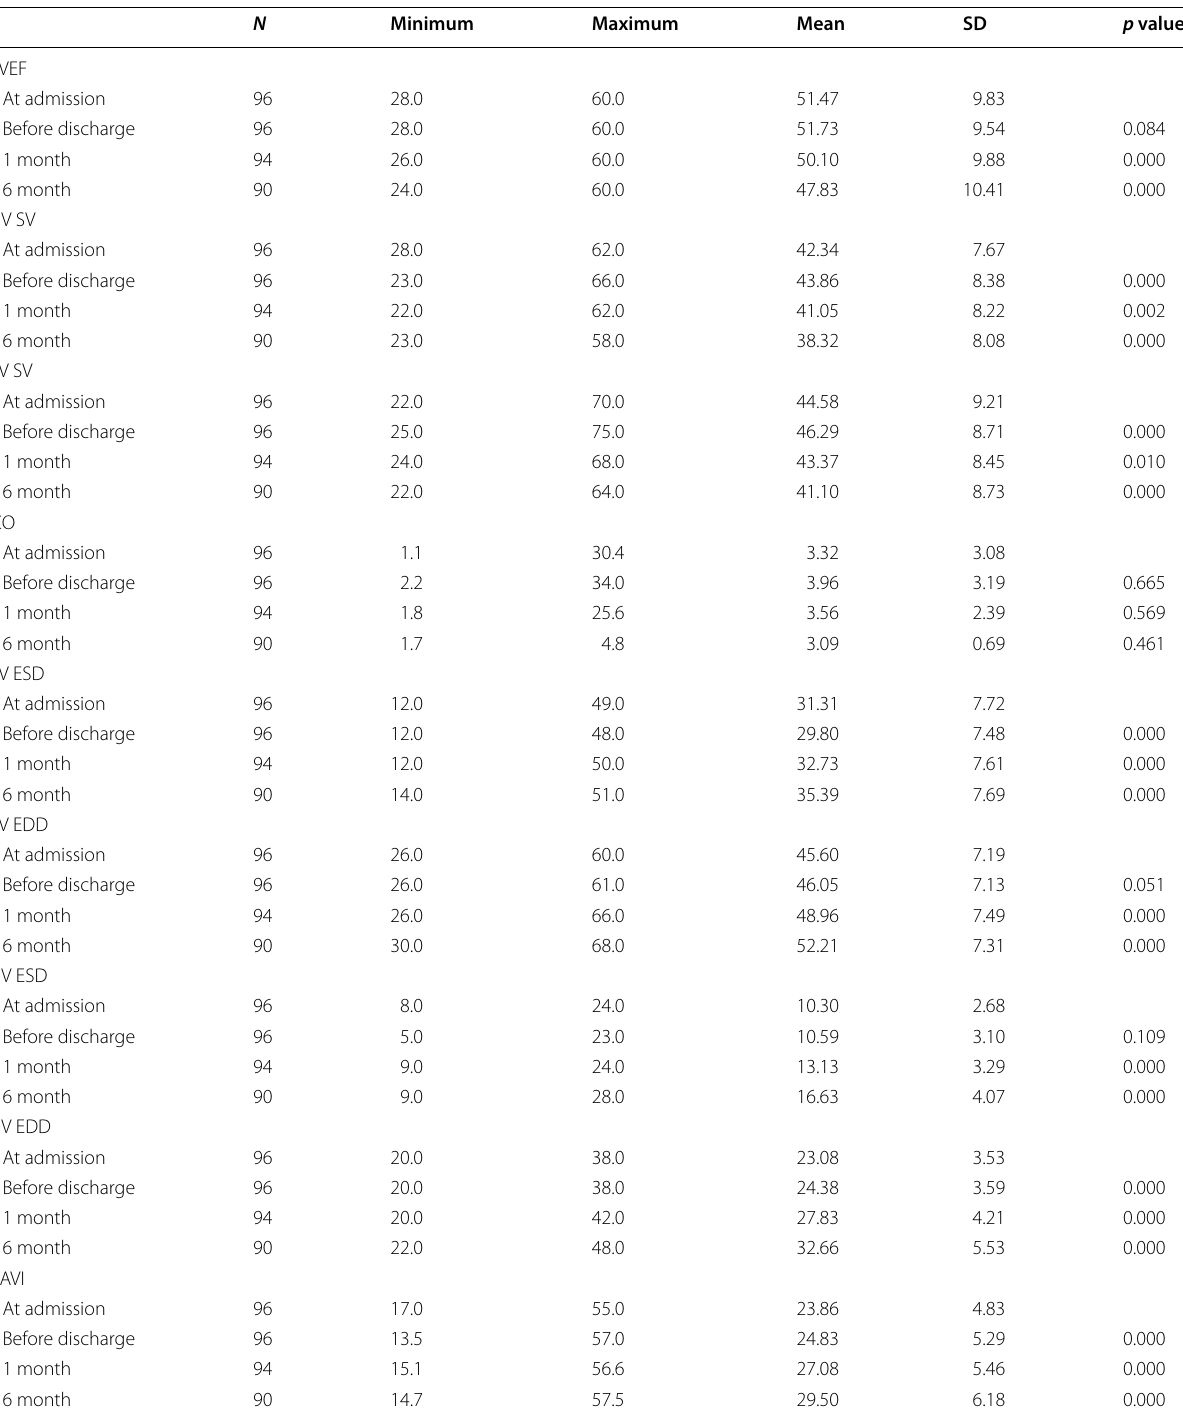
Table 3 Echocardiographic